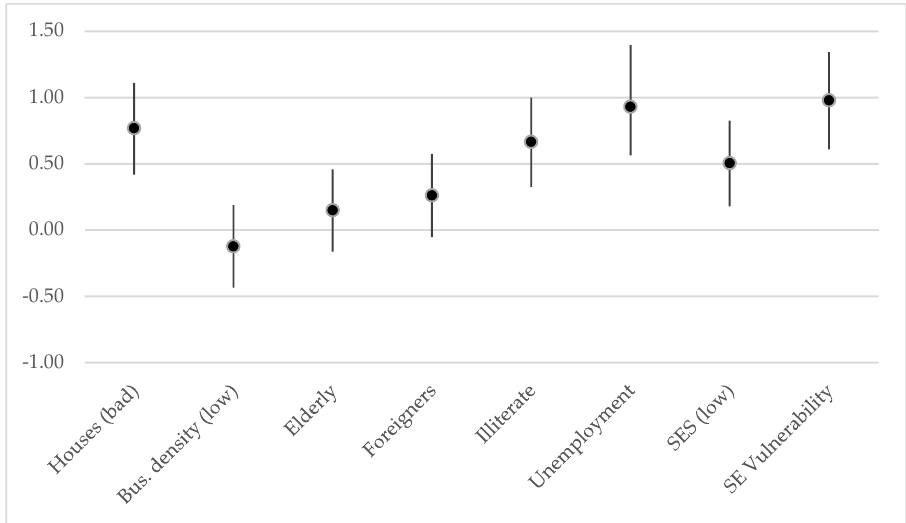
Figure 2. URBANA Programme: Differences between chosen and non-chosen areas. Effect sizes: Hedges’ g (95% confidence interval).